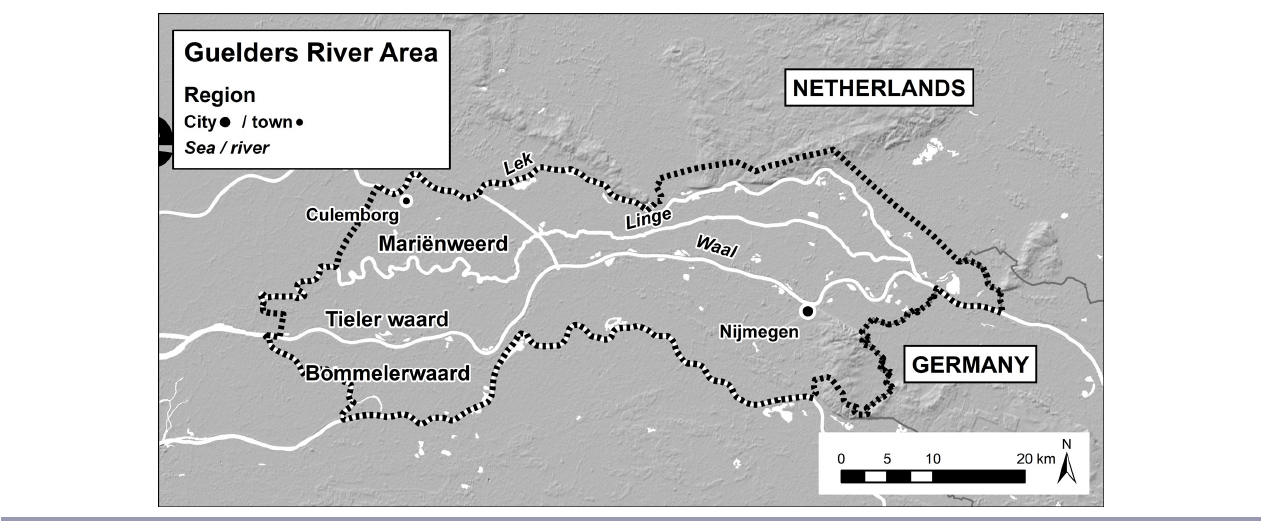
Fig. 3 . Map of the Guelders river area, indicating the localities mentioned in the text. Iason Jongepier, GIStorical Antwerp (UAntwerpen/Hercules